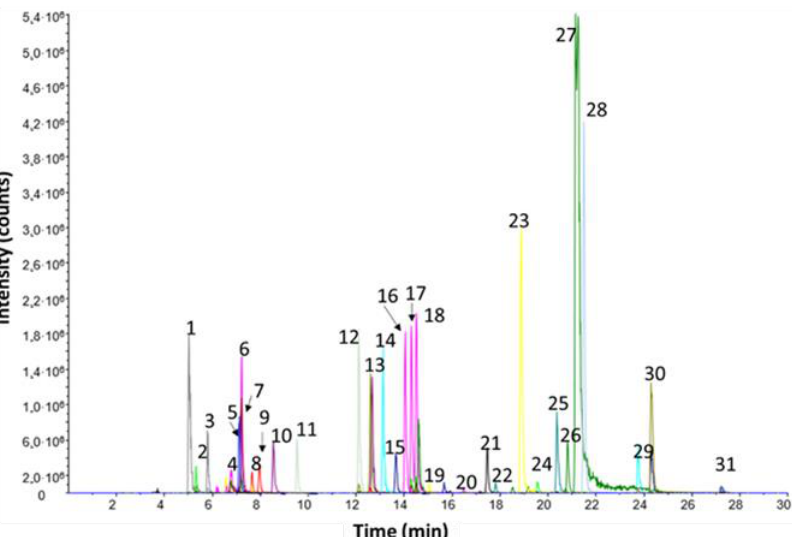
Figure 1. Chromatogram of a mixture of standards of biogenic amines and amino acids at 10 mg L −1 each. Assignation: (1) arginine, (2) asparagine, (3) glutamine, (4) serine, (5) agmatine, (6) glutamic acid, (7) aspartic acid and hydroxyproline, (8) threonine, (9) ethanolamine, (10) glycine, (11) alanine, (12) proline, (13) valine and methionine, (14) tryptophan, (15) etamine, (16) phenylalanine, (17) isoleucine, (18) leucine, (19) cysteine, (20) ornithine, (21) histidine, (22) tryptamine, (23) phenylethylamine, (24) putrescine, (25) cadaverine and tyrosine, (26) histamine, (27) hexylamine, (28) octopamine, (29) tyramine, (30) spermidine, and (31) spermine.